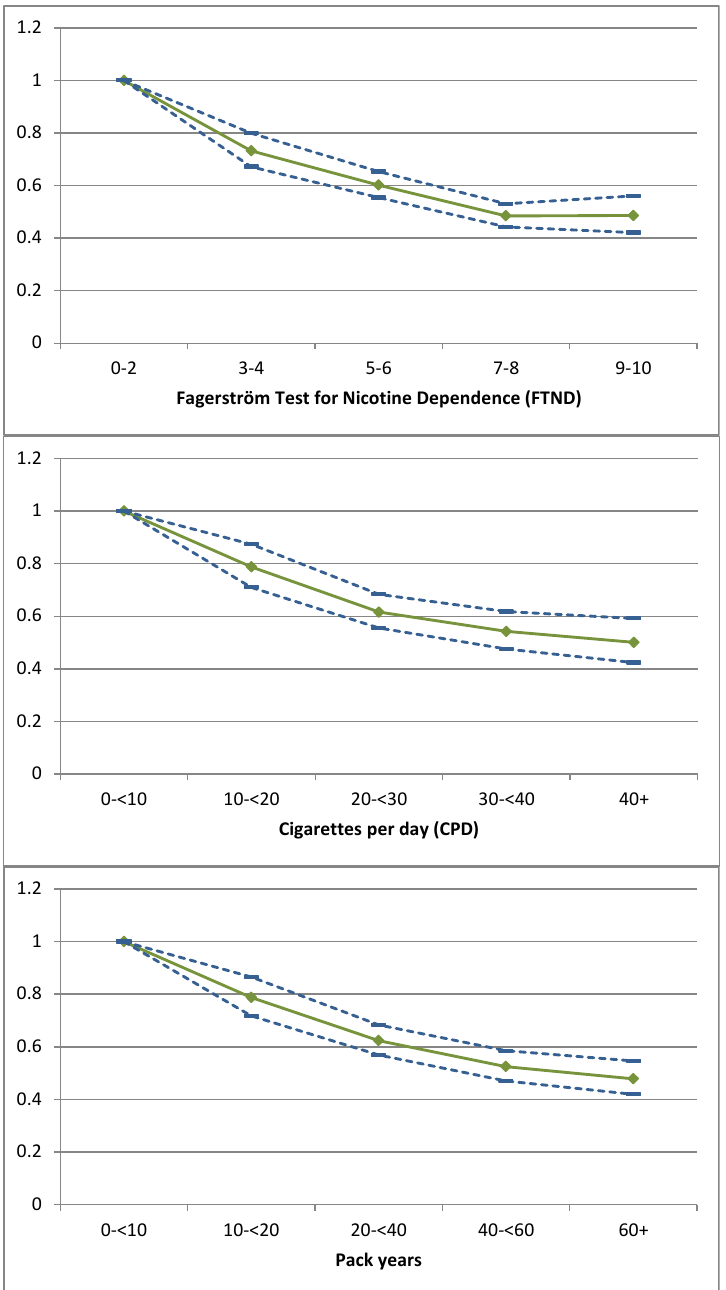
Figure 2. Odds ratio (  ) and 95% CI (▬) of continuous abstinence as the dependent variable for Fagerström points (FTND), cigarettes per day (CPD) and pack-year after adjusting (final model) for setting, region, format, payment modality, age, gender, employment, attempts to quit, living with a smoker, compliance and calendar